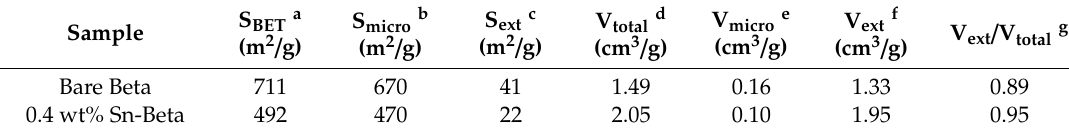
Table 1. Textural properties of the bare Beta and the 0.4 wt% Sn-Beta. Sample